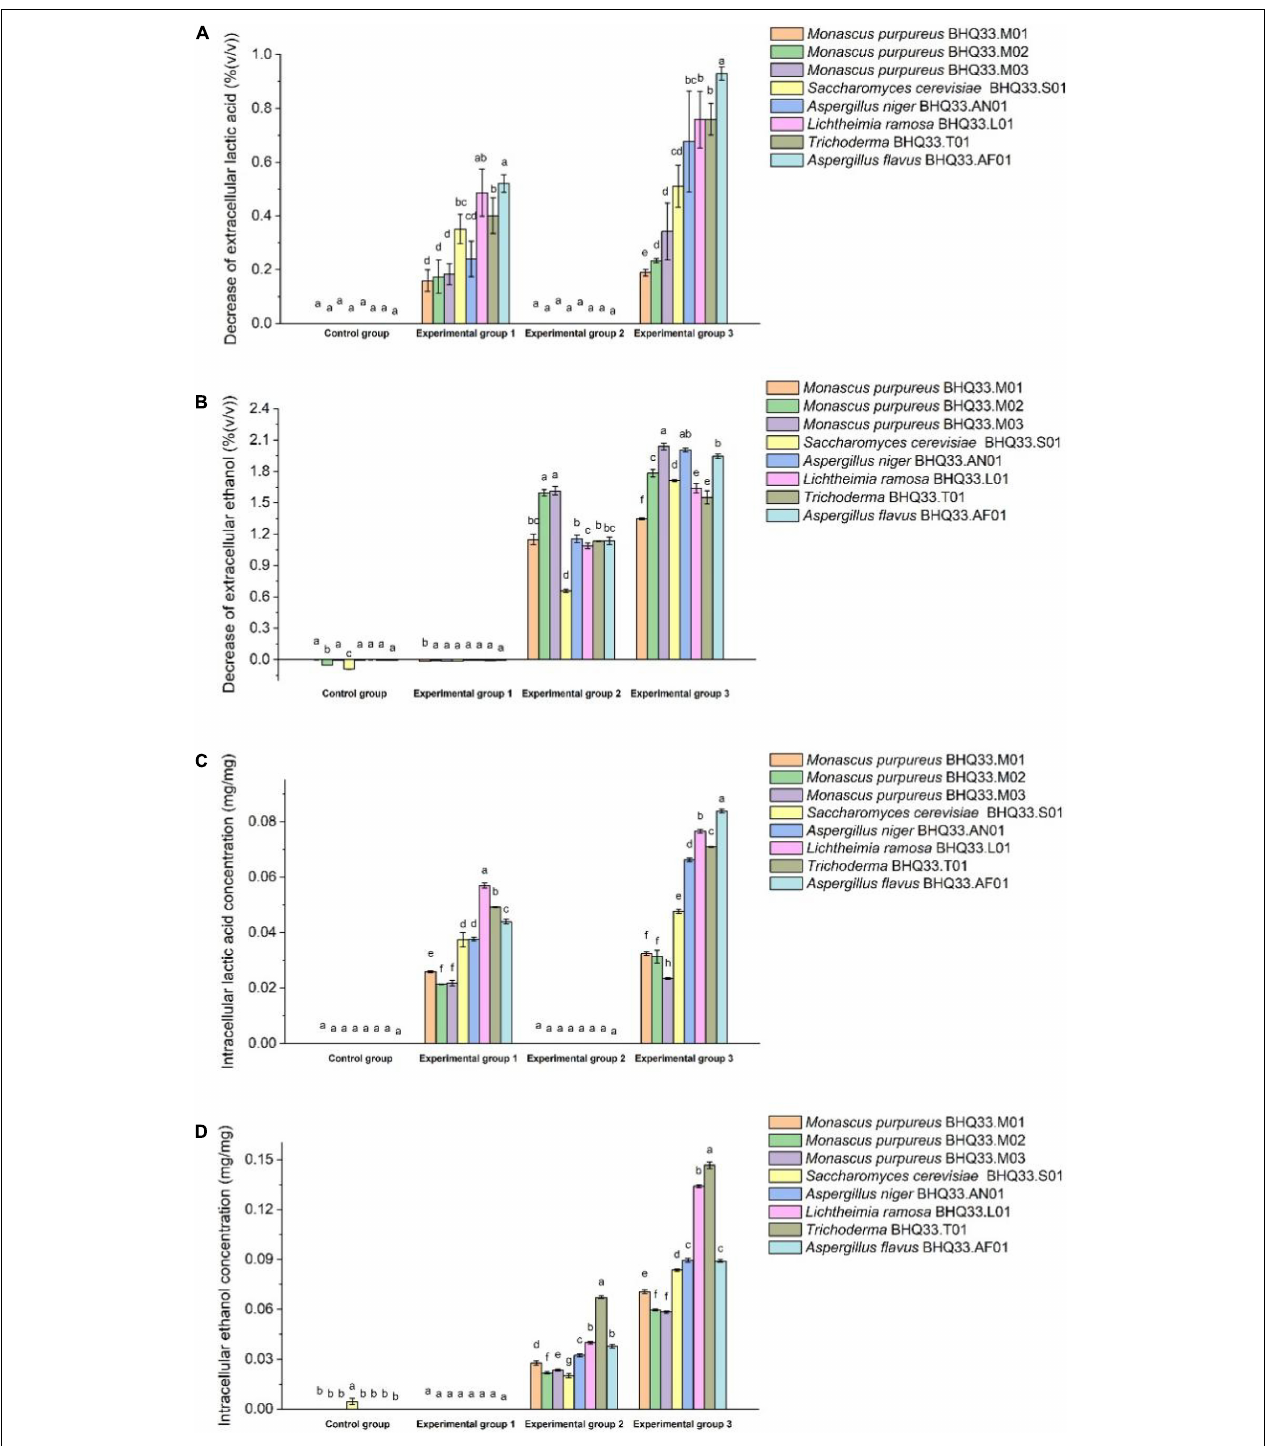
FIGURE 5 | Changes in intracellular and extracellular lactic acid and ethanol contents before and after fermentation by different fungi isolated from Hongqu BHQ33. Different fungi isolated from Hongqu BHQ33 were cultured in medium containing different concentrations of lactic acid and ethanol at 30 ◦ C and 200 r/min for 24 h, and the decrease of extracellular lactic acid (A) , the decrease of extracellular ethanol (B) , the accumulation of intracellular lactic acid (C) and the accumulation of intracellular ethanol (D) were detected. In the initial medium, control group was basal medium without lactate and ethanol, experimental group 1 was supplemented with 3.98% (v/v) lactic acid in basal medium, experimental group 2 with 6.24% (v/v) ethanol, and experimental group 3 with both 3.98% (v/v) lactic acid and 6.24% (v/v) ethanol. Error bars indicate the standard deviation (SD) of the means ( n = 3), and different lowercase letters represent significant differences in the detection indexes of fungi isolated from Hongqu BHQ33 under the same treatment conditions ( p <